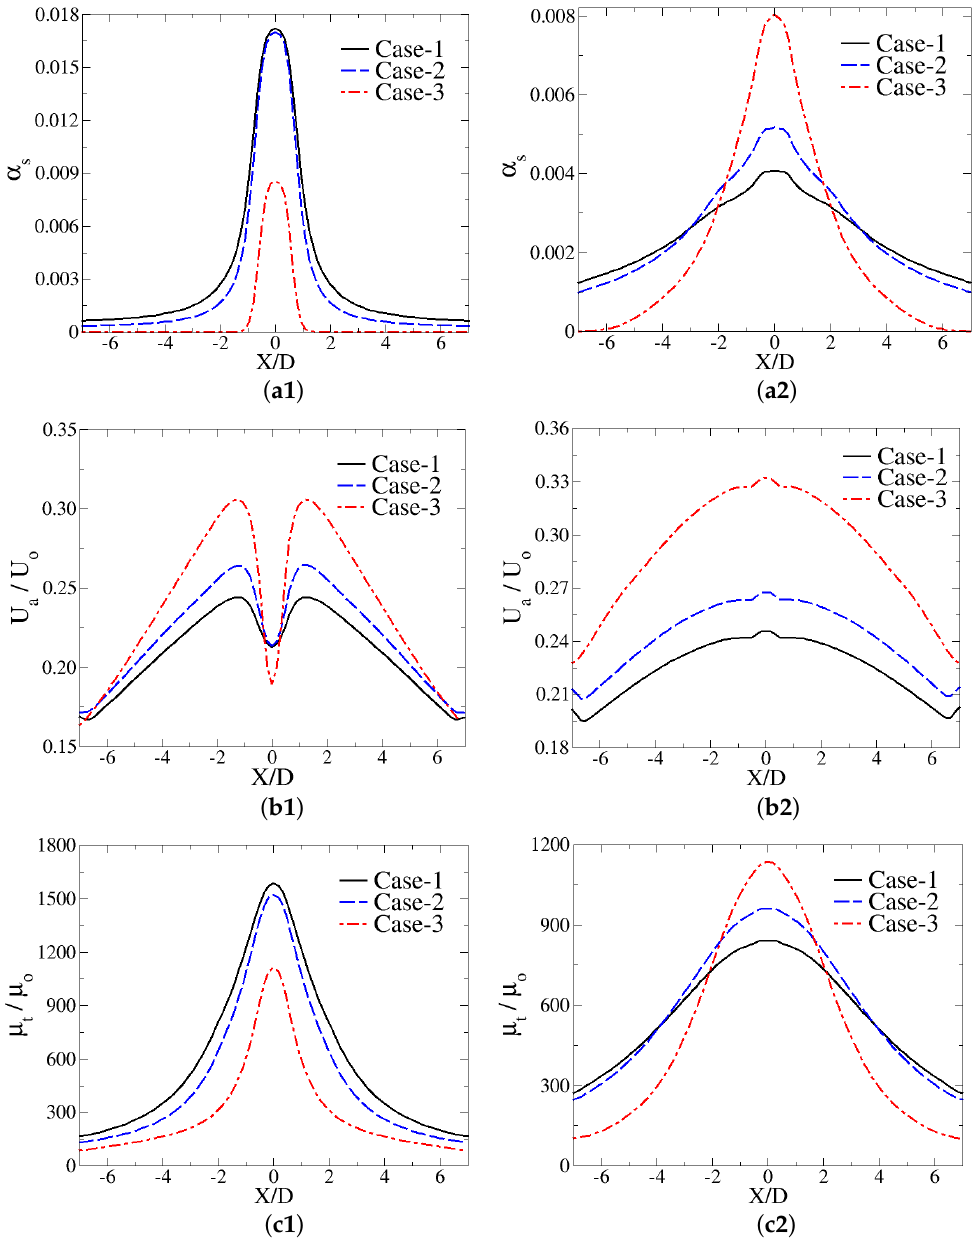
Figure 9. Predicted solid volume fraction profiles at Z / D = 14—( a1 ) and Z / D = 18—( a2 ); di- mensionless air velocity profiles at Z / D = 14—( b1 ) and Z / D = 18—( b2 ); turbulent viscosity ratio profiles at Z / D = 14—( c1 ) and Z / D = 18—( c2